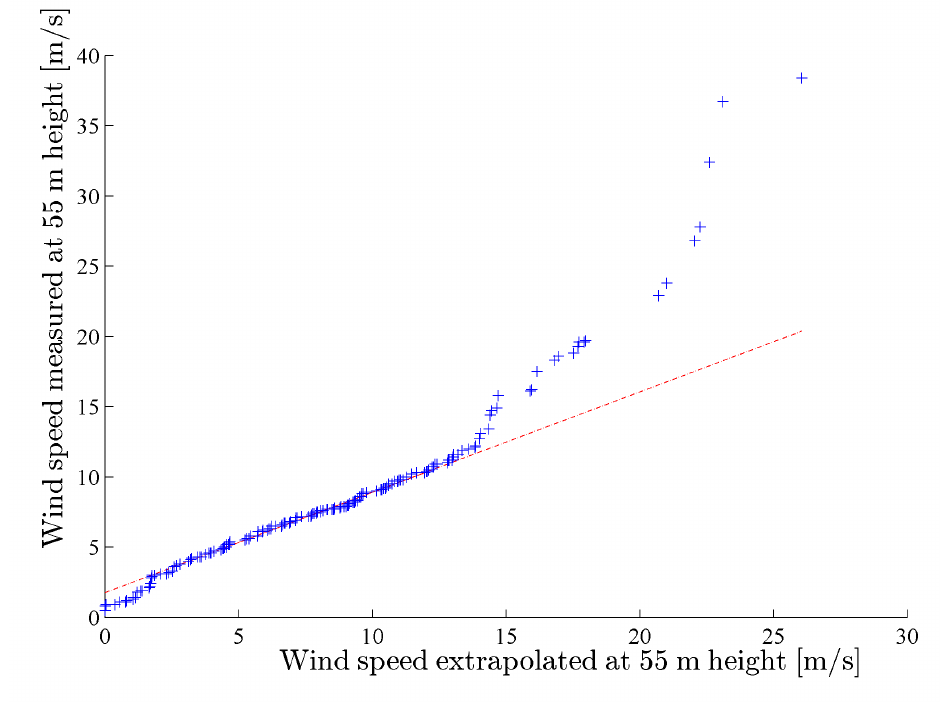
Figure 6. QQ-plot of measured data at 55 m vs. extrapolated data to a 55-m